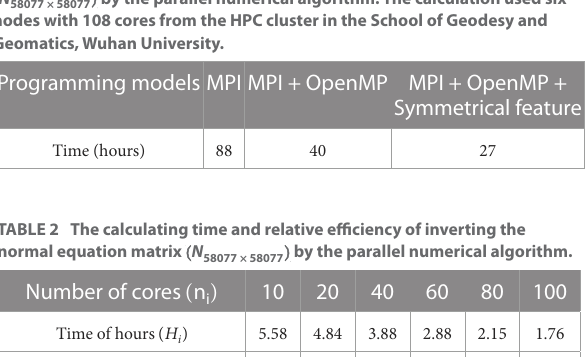
FIGURE 6 Coefficient differences between IGGT_R1_test and EIGEN-5C, provided as absolute values in logarithmic scale ( log 10 ) .